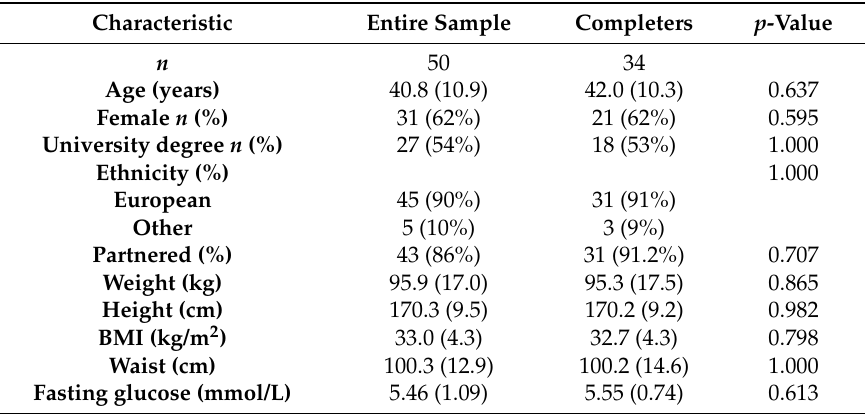
Table 2. Baseline characteristics of the